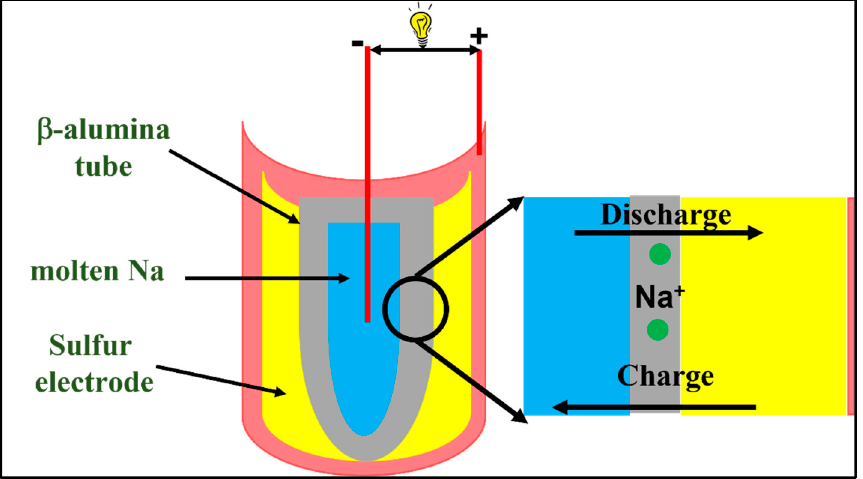
Figure 2. Schematic representation of HT Na/S battery with molten solid electrolyte, molten sodium anode and molten sulfur